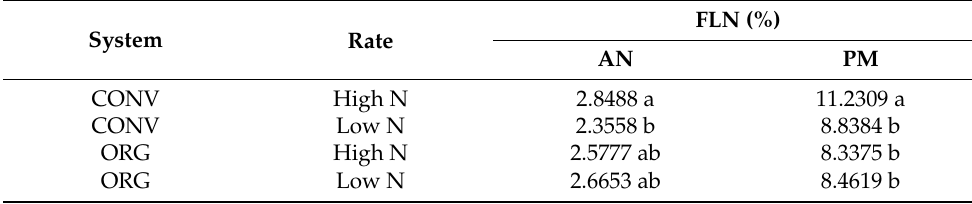
Table 6. Flag leaf nitrogen (FLN) content in each production system as affected by rate during anthesis (AN) and physiological maturity (PM) sampling points in Y2 ( p = 0.0064). (Same letters within each column are not significantly different based on Tukey’s honest significant difference (HSD) test performed at α =